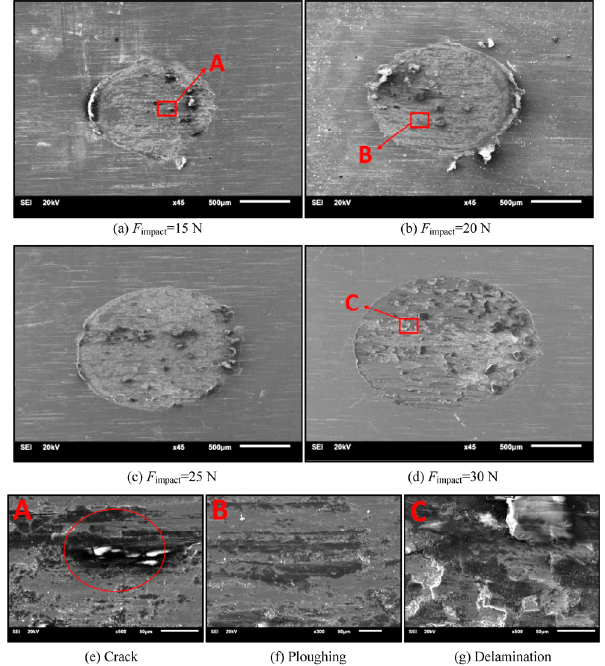
Fig. 18 SEM micrographs of the worn scars under varied impact forces, cycles=10 5 .